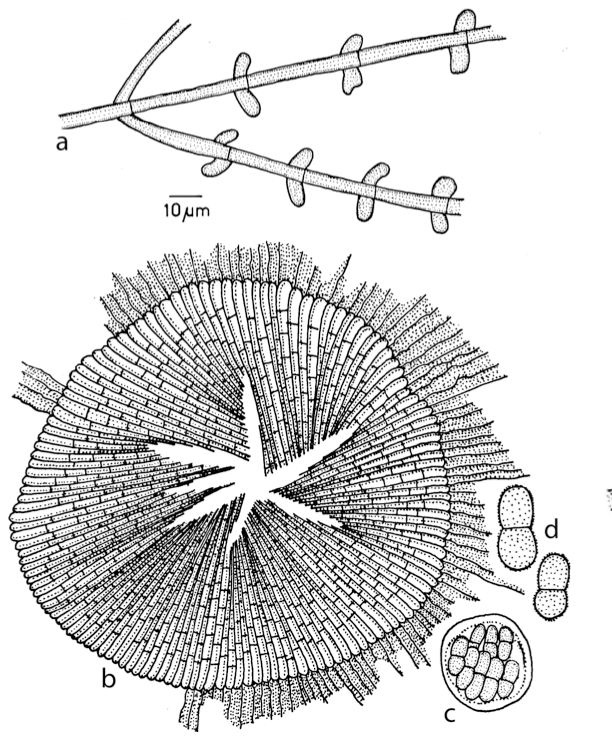
Figure 129. Asterina acronychiae a - Appressorium; b - Thyriothecium; c - Ascus; d - Ascospores